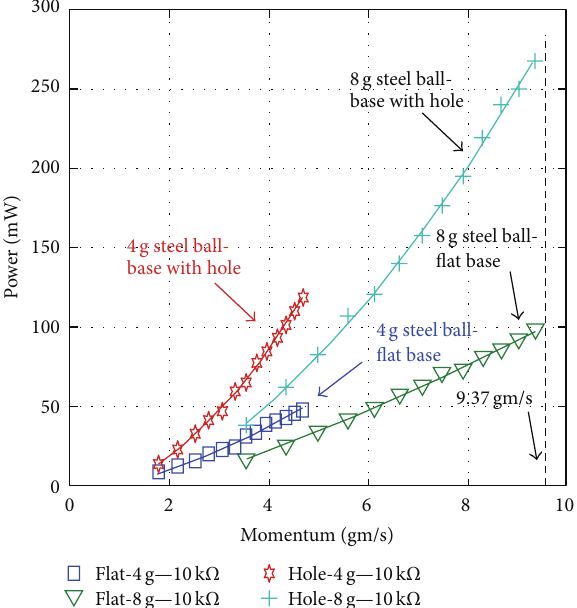
Figure 8: Average output power (2 ms) versus momentum plots for 4 g and 8 g steel balls comparing the flat base and the base with a hole.